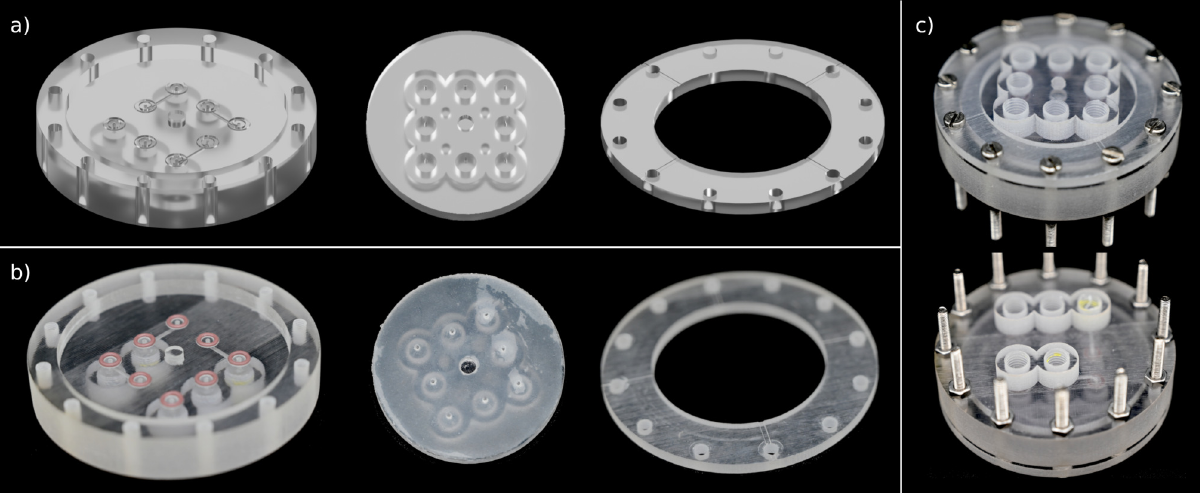
Figure 4. Design and implementation of the upscaled valve: ( a ) CAD drawing of stator, rotor, and cover; ( b ) 3D-printed rotor, stator, and cover: sealing area of rotor is covered with a silicone mat, and o-rings are placed in respective grooves in stator. Parts were printed with polyjetting; ( c ) top and bottom view of assembled upscaled